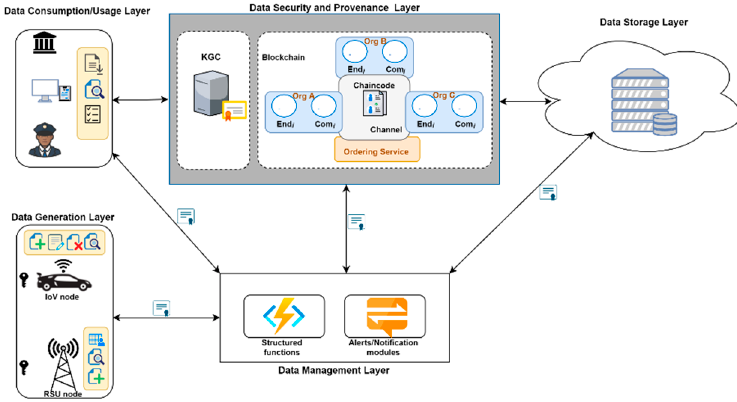
Figure 5. VBlock design with five main layers and individual components.